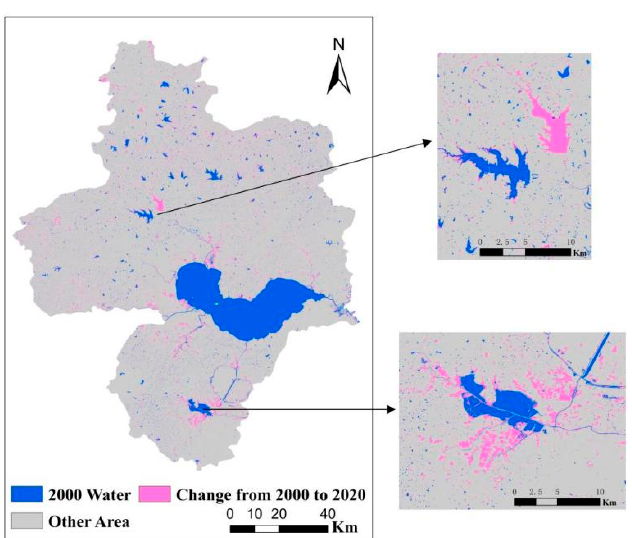
Figure 7. Spatiotemporal distribution variation in water body in Hefei from 2000 to 2020.